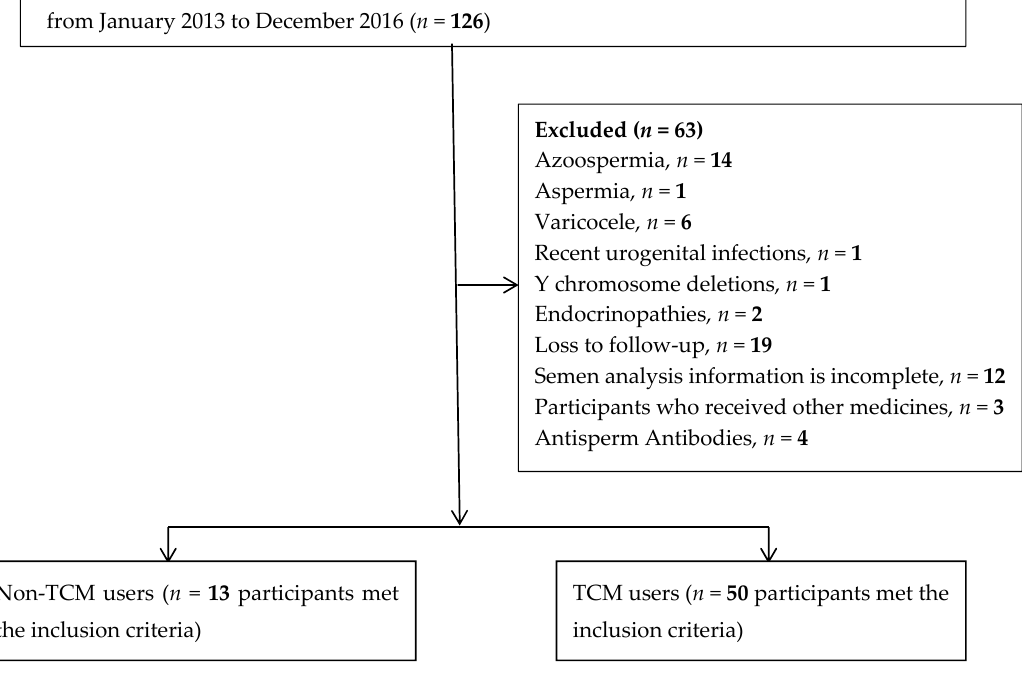
Figure 1. Flow diagram for the selection of eligible studies and subjects.